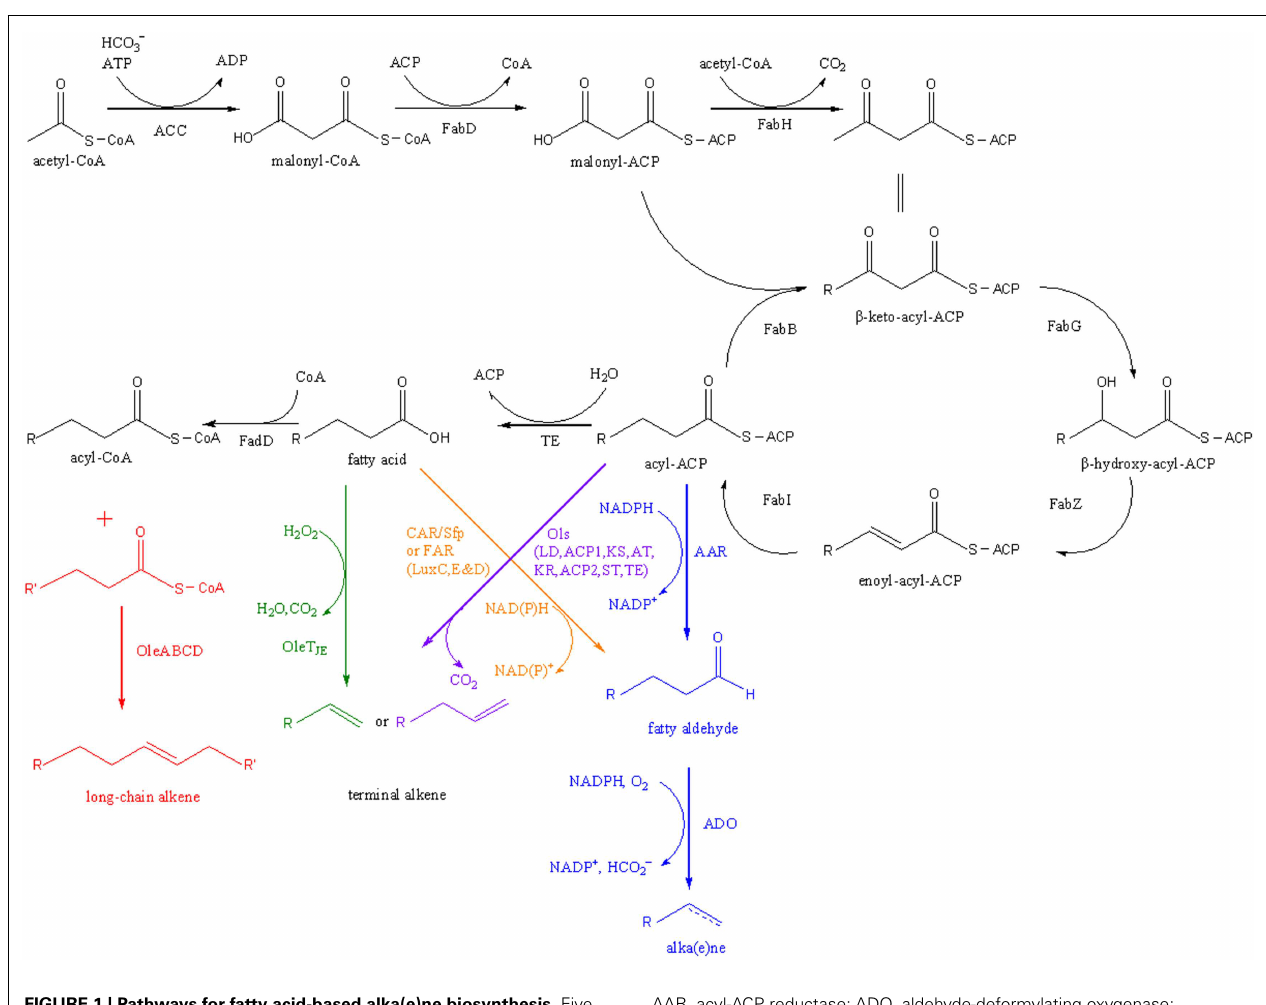
FIGURE 1 | Pathways for fatty acid-based alka(e)ne biosynthesis . Five alka(e)ne biosynthetic pathways are shown in different colors. ACC, acetyl-CoA carboxylase; FabD, malonyl-CoA:ACP transacylase; FabH, β -keto-acyl-ACP synthase III; FabB, β -keto-acyl-ACP synthase I; FabG, β -keto-acyl-ACP reductase; FabZ, β -hydroxyacyl-ACP dehydratase; FabI, enoyl-acyl-ACP reductase;TE, thioesterase; FadD, acyl-CoA synthase;